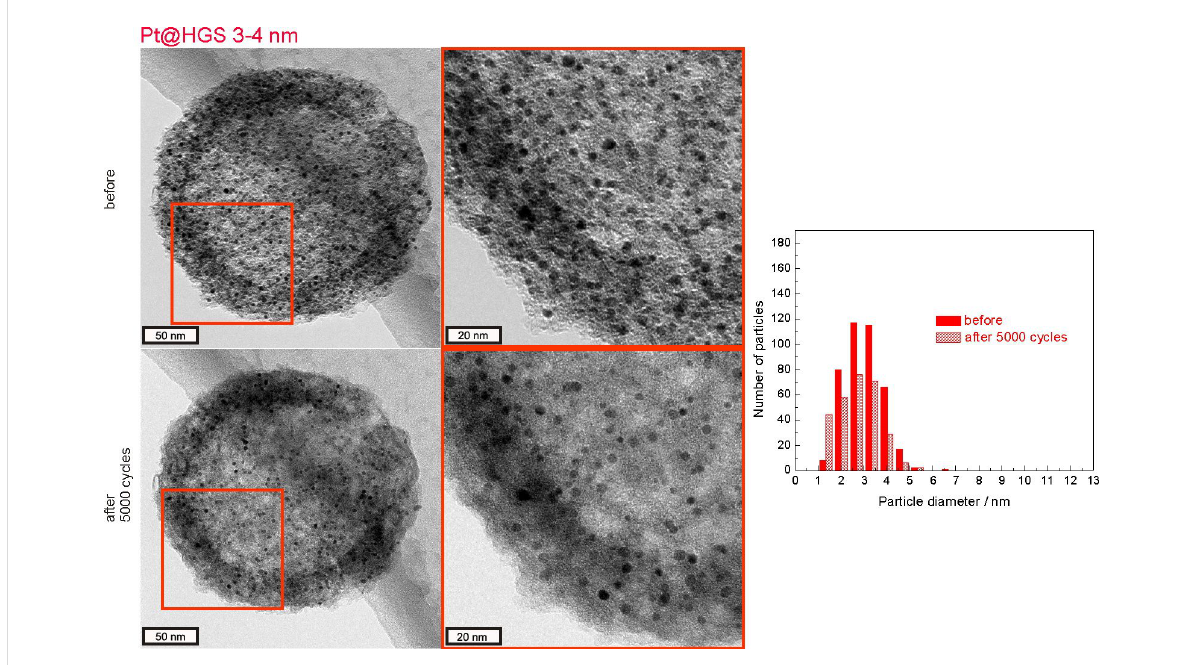
Figure 8: IL-TEM micrographs of the Pt@HGS 3–4 nm catalyst before and after 5000 potential cycles between 0.4 and 1.4 V RHE in 0.1 M HClO 4 (scan rate 1 V·s − 1 , room temperature). The red rectangles in the micrographs mark regions, which are magnified on the right. Filled bars refer to the particle size before, shaded bars to the particle size after